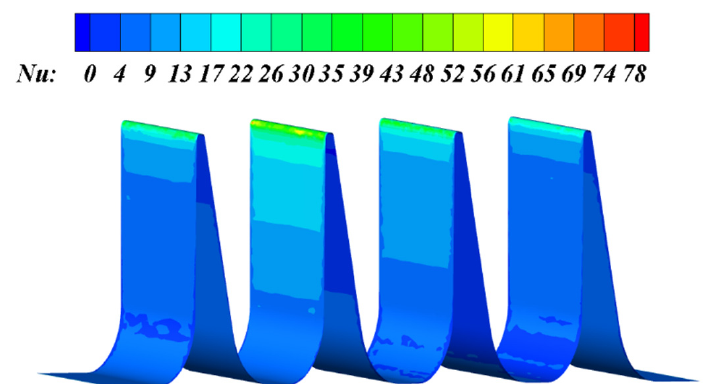
Figure 15. Nusselt number distribution on labyrinth seal surface.